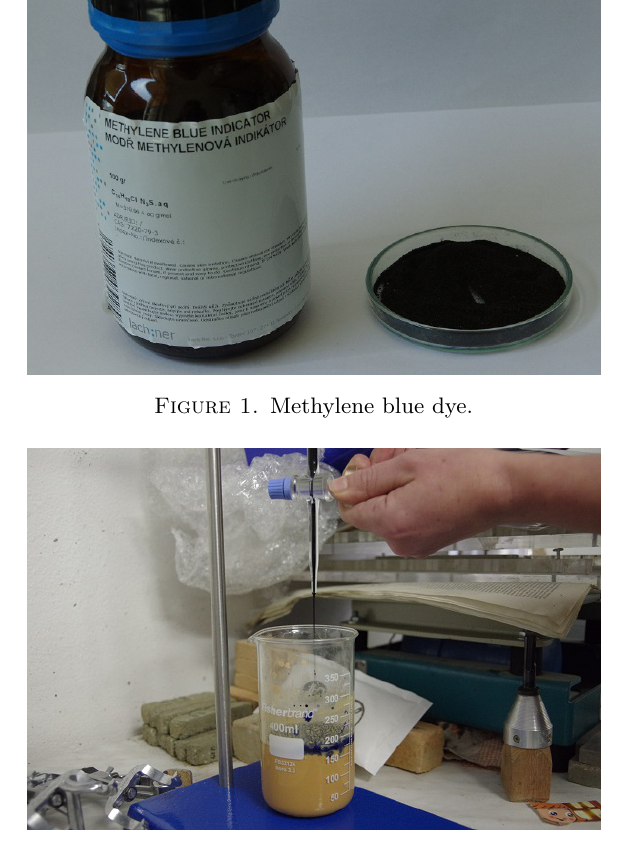
Figure 2. Methylene blue dye is dosed into earth sample.